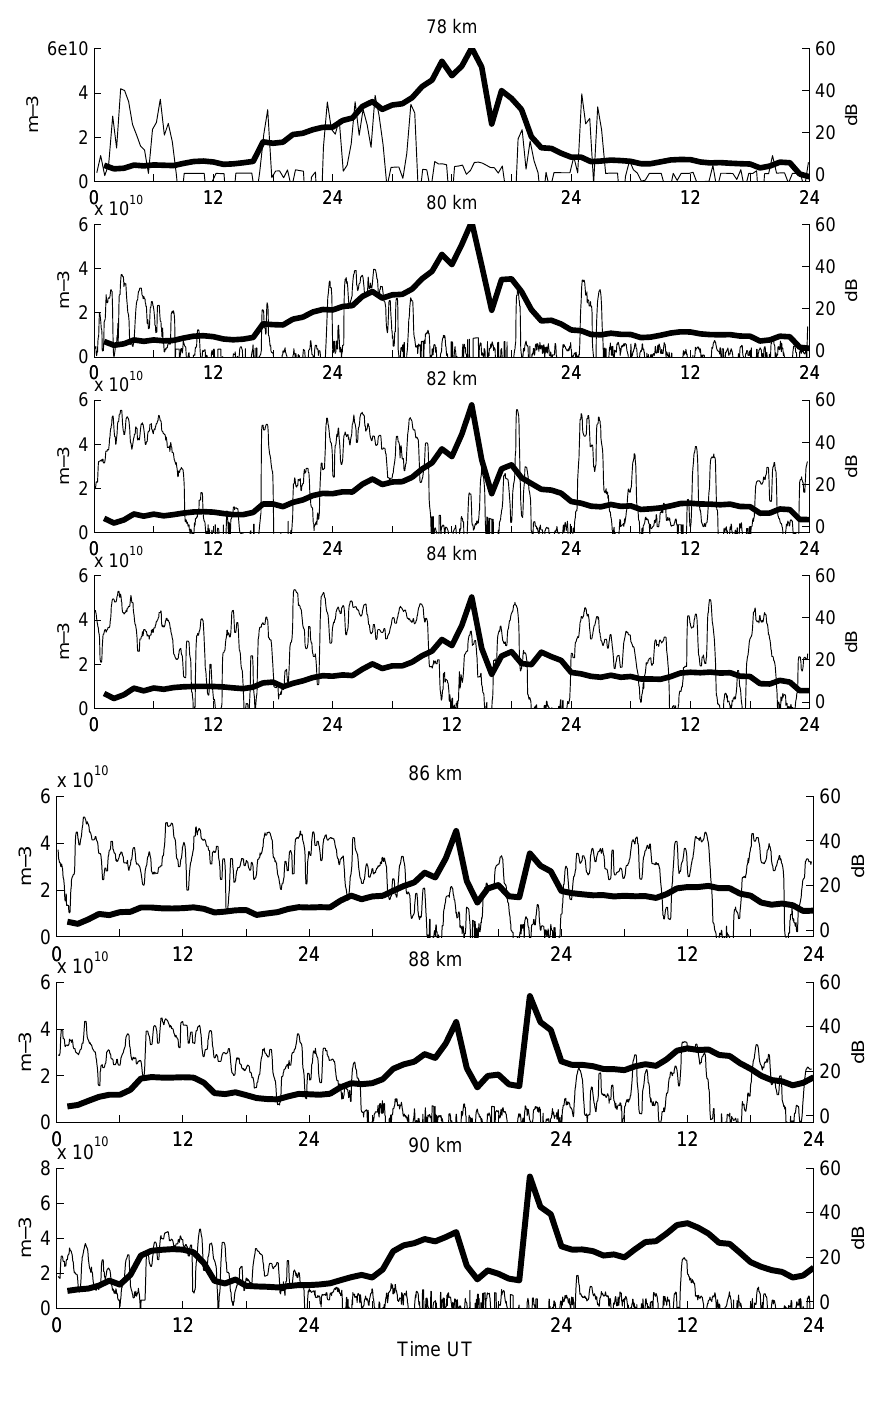
Fig. 4. Combined plots of the electron number density (bold line) and the ESRAD echo power (normal line) for different